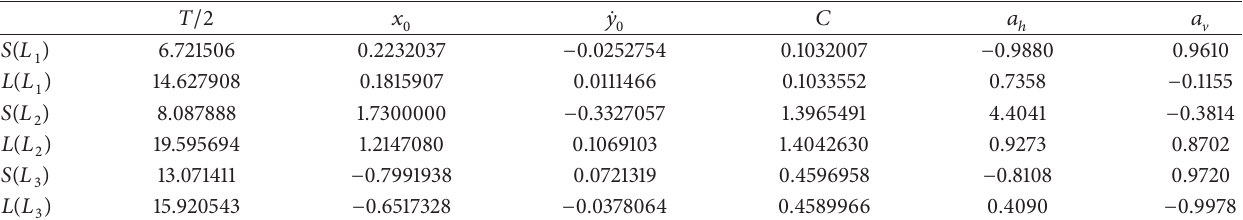
Figure 14: Sample members of the short period families emanating from the stable equilibrium points 𝐿 1 [(a)–(d)] and 𝐿 2 [(e)–(h)]. Table 4: Sample members of the short and long period families emanating from the collinear equilibrium points for 𝜇 = 0.2 and 𝜔 = 0.5 and the following radiation factors: 𝑞 1 = 0.015 and 𝑞 2 = 0.05 for 𝐿 1 , 𝑞 1 = 0.9 and 𝑞 2 = 0.03 for 𝐿 2 , and 𝑞 1 = 0.03 and 𝑞 2 = 0.9 for 𝐿 3